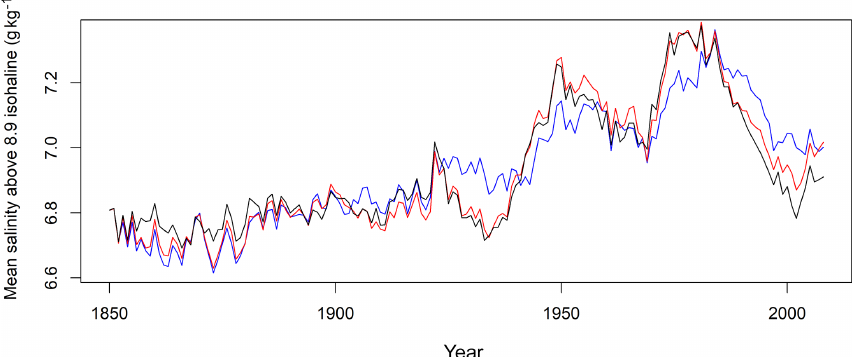
Figure 16. Baltic Sea annual mean salinity above the 8.9g kg − 1 isohaline (g kg − 1 ). Black: results of numerical model. Red: after the approximation that the outflow salinity is the mean salinity modified by a factor α . Blue: additionally under the assumption of a constant river